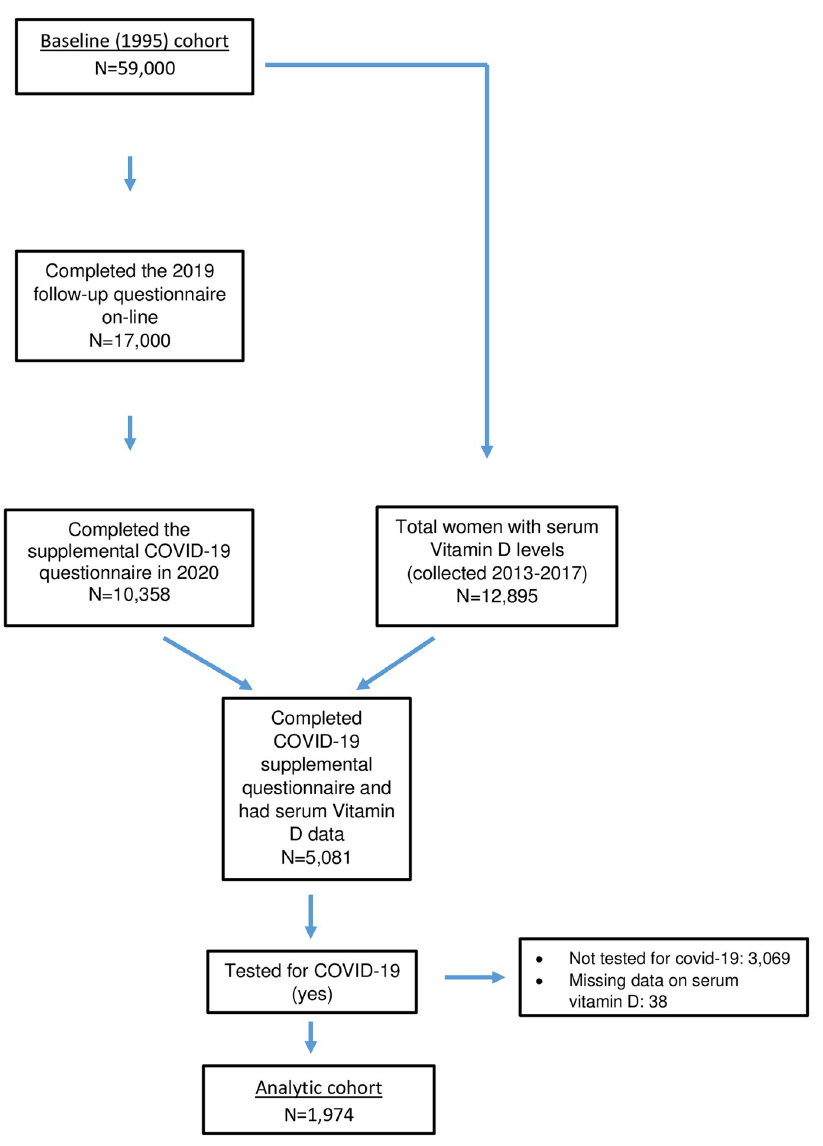
Fig 1. Black Women’s Health Study follow up flow chart,